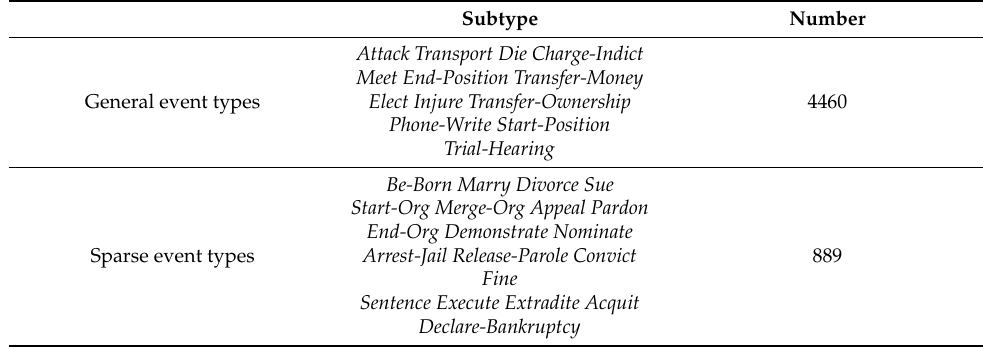
Table 6. The number of instances of general event types and sparse event types in the ACE2005